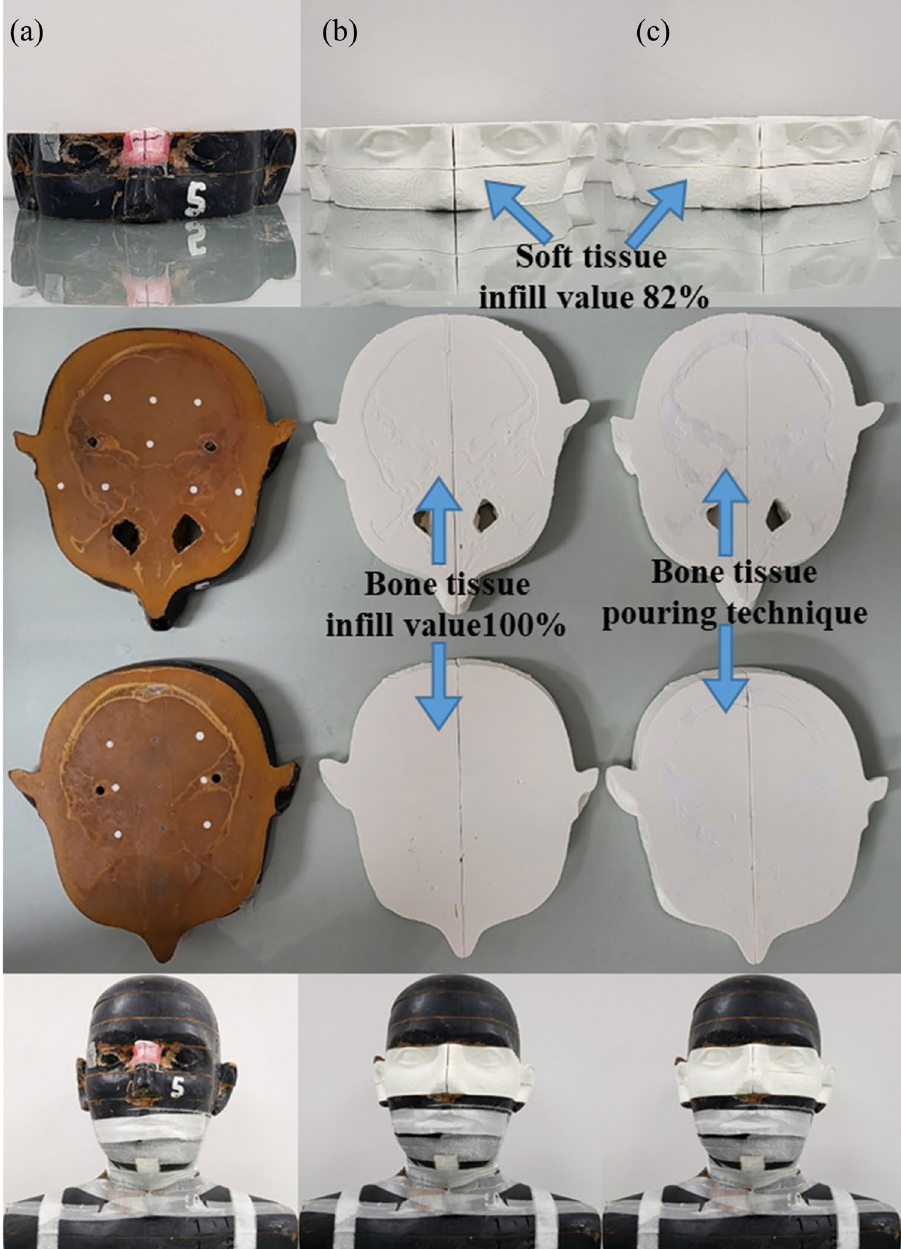
Figure 8. ( a ) Commercial Rando head phantom, ( b ) Rando head phantom printed using only PLA material, ( c ) Rando head phantom printed with a mixture of plaster and PLA